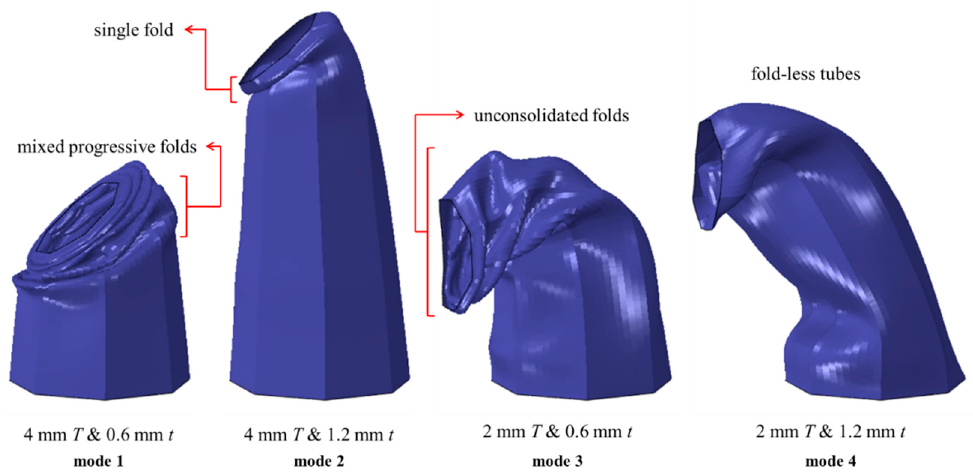
Figure 12. The four modes of deformation for tubes of CR = 1, θ = 5° and R = 3 and different T and t.